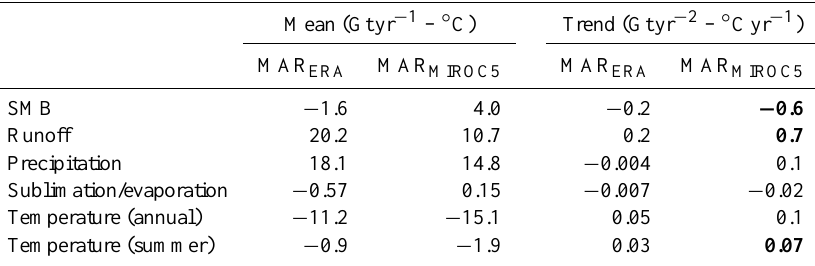
Table 9. 1980–2005 mean SMB, its components (Gtyr − 1 ) and annual and JJA TAS ( ◦ C) with their linear trends (Gtyr − 2 and ◦ Cyr − 1 ) from MAR ERA and MAR MIROC5 . The statistically significant (i.e. superior to twice the interannual variability of the variable in MAR ERA or MAR MIROC5 ) linear trends are in